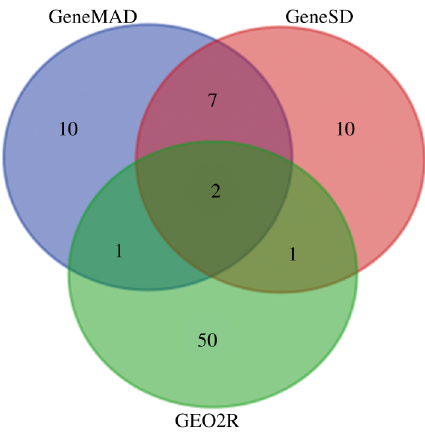
Figure 3: Common Genes in series GSE2443. GeneMAD and GeneSD revealed the expression of probeIDs from 20 samples of series GSE2443 (Figure 4 and Figure 5 ). The range is between 0 and 0.998 for the expression values for each sample in the data set.